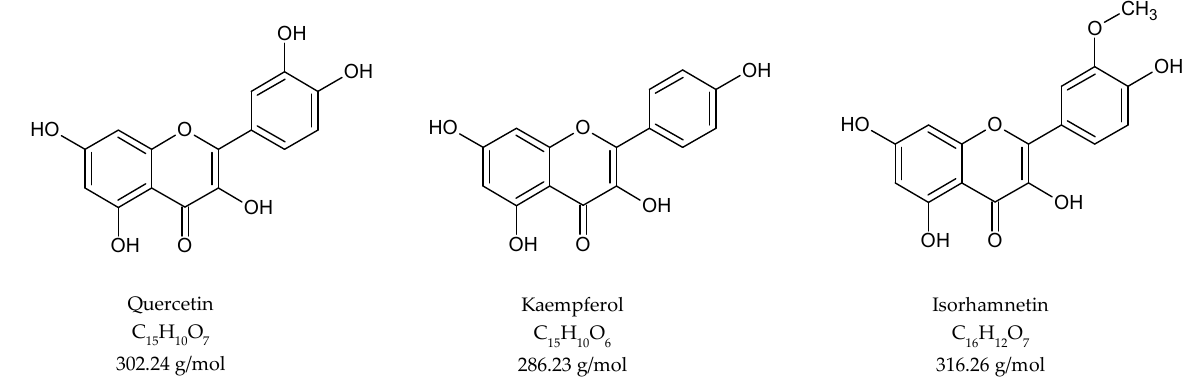
Figure 4. Chemical structure of flavonoids in G. biloba acidic hydrolyzed extract. The amount of total flavonoids increased from the closed-bud stage (0.21 ± 0.01% dry wt) and the semi-open bud stage (0.37 ± 0.03% dry wt) to the opened-bud stage (0.48 ± 0.03% dry wt), with the greatest difference observed between the closed buds and the